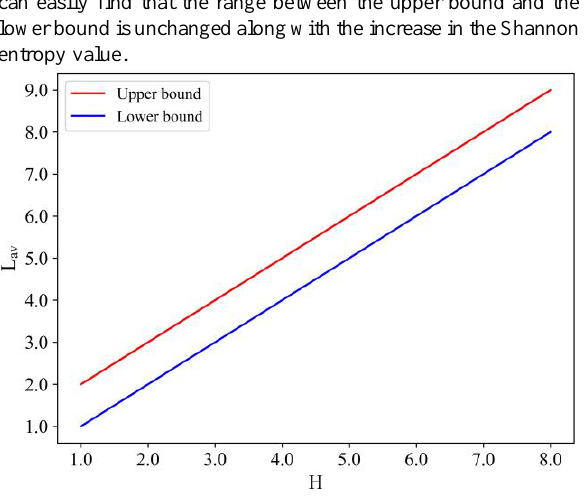
Figure 1. Shannon’s source coding theorem on the average codeword length